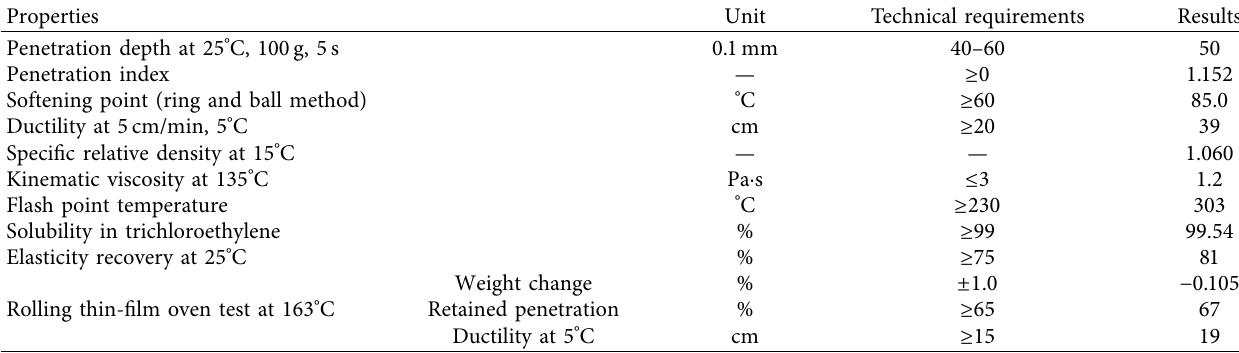
Table 4: Technical properties of SBS modified asphalt.